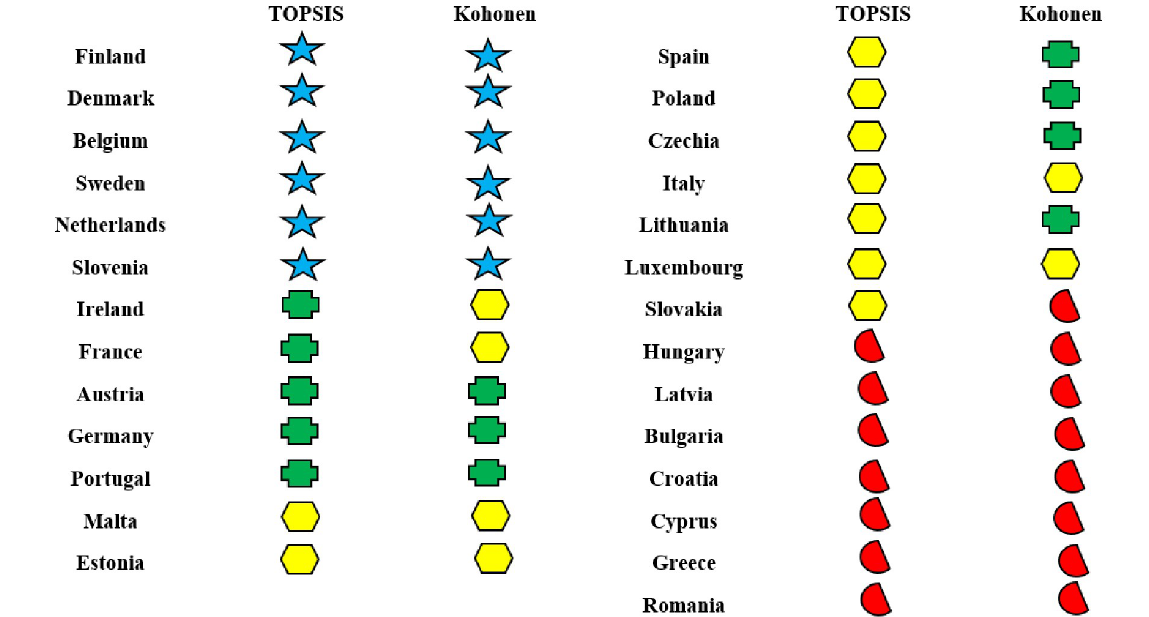
Fig 13. The summary of the results of the study of the level of digitalization and robotization of the EU countries and the similarity between these countries.